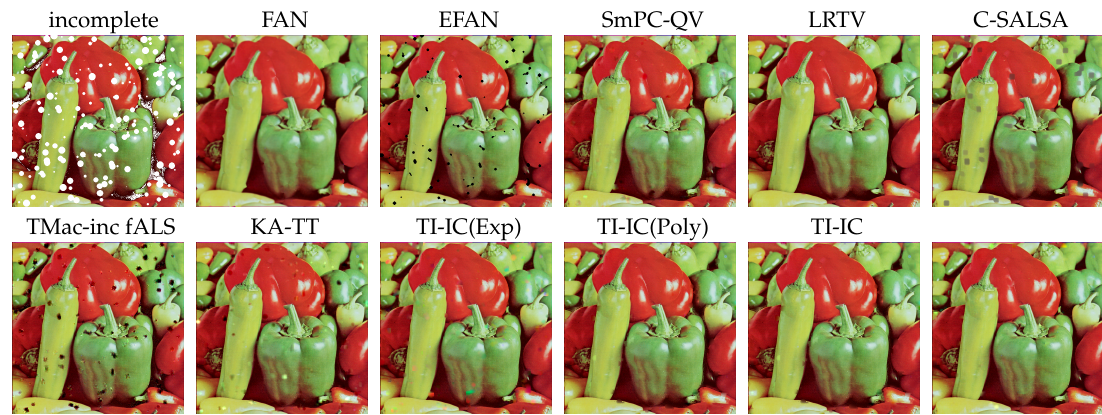
Figure 4. Test C (200 missing circles of maximum 10-pixel radius) for the image “Peppers”.